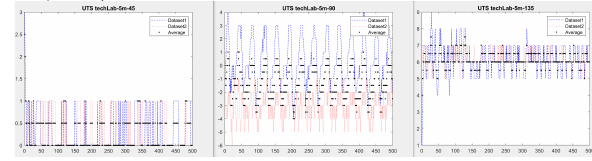
Figure 7 . Results of the tests in the ideal